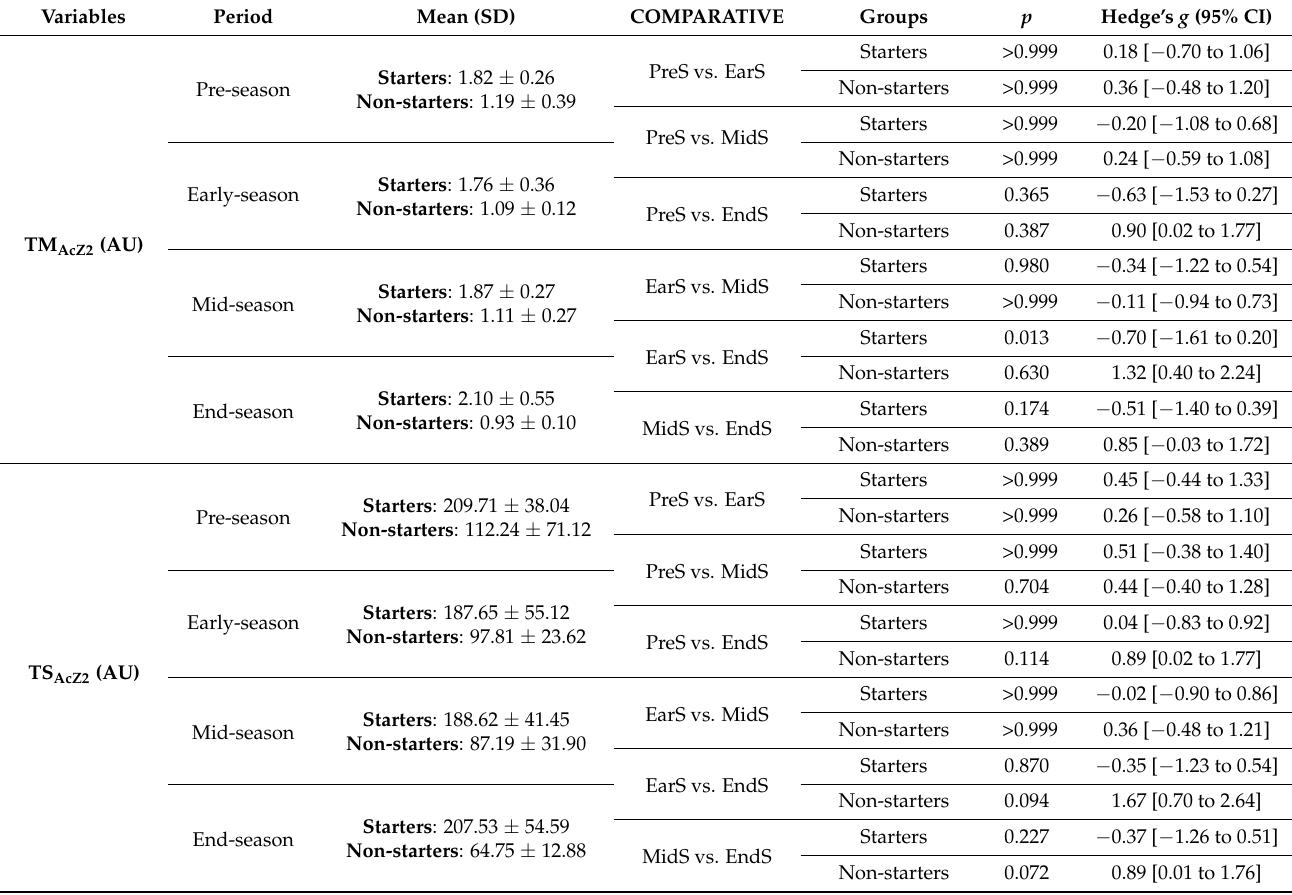
Table 2. Intragroup differences for binary comparisons between season periods in TM and TS in AcZ2 for both non- and starter players.